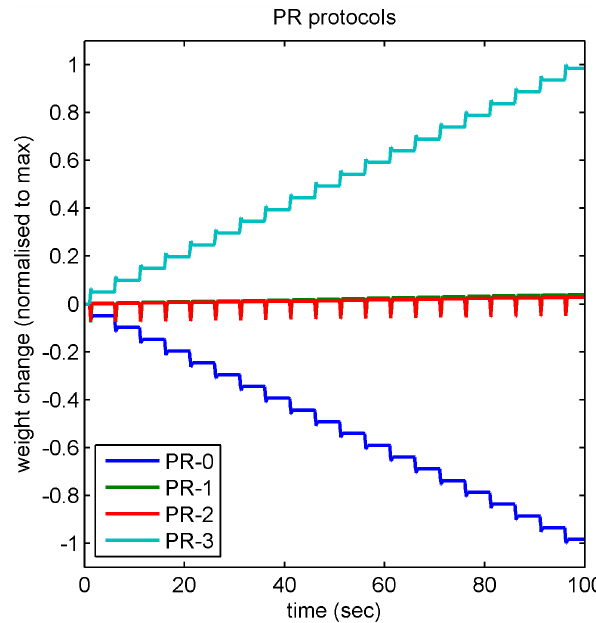
Figure 7. Modeling the effects of the original and modified PR protocols. The build up of weight change in vestibular synapses over time is shown for the three PR protocols. For PR-0 (a 250 msec hyperpolarization overlapping the 550 msec vestibular pulse train, see Fig. 4A) the main contribution at each presentation is LTD and there is a relatively large weight change. For PR-1 (250 msec hyperpolarization followed by 250 msec depolarization of equal amplitude) and PR-2 (250 msec hyperpolarization followed by 125 msec depolarization of twice the amplitude) the LTD contribution is approximately balanced by LTP leading to much smaller weight changes. For protocol PR-3 (a 250 msec depolarization overlapping the 550 msec vestibular pulse train, see Fig. 6F) overall LTP is predicted. In this simulation the hyperpolarizing and depolarizing current pulses were interpreted as due to proportional changes in firing rate of the appropriate input, and weight changes were calculated using the firing rate version of the learning rule (Equation 6).